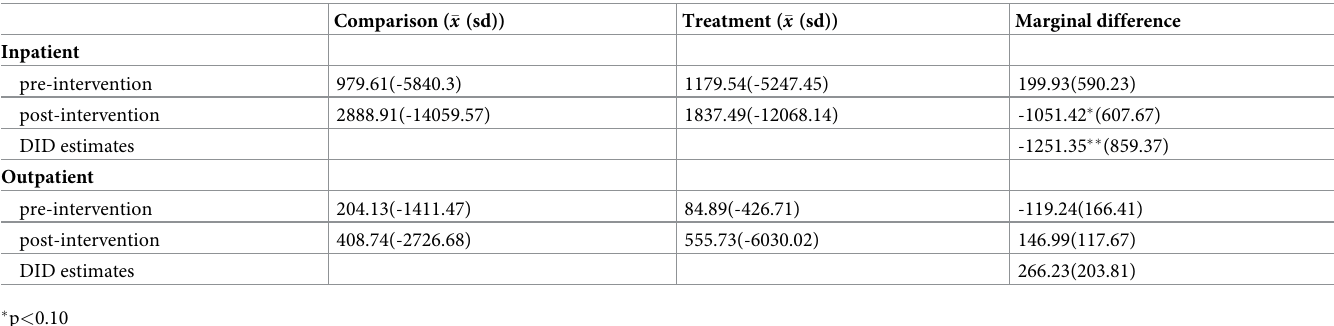
Table 3. Impact of the NEPHSP on the outpatient and inpatient expenditure after